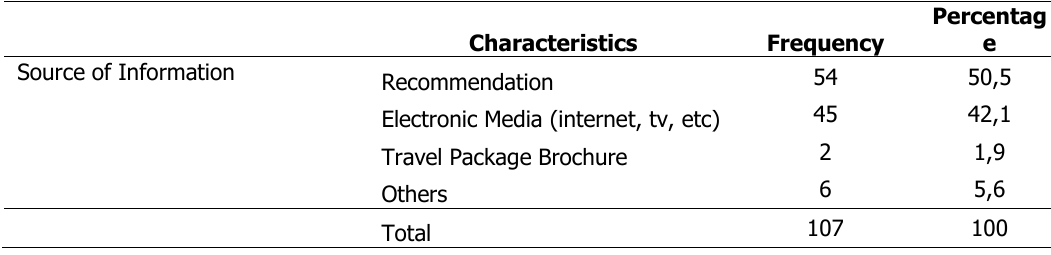
Table 5. Demographic Characteristics of Observations Based on Source of Information